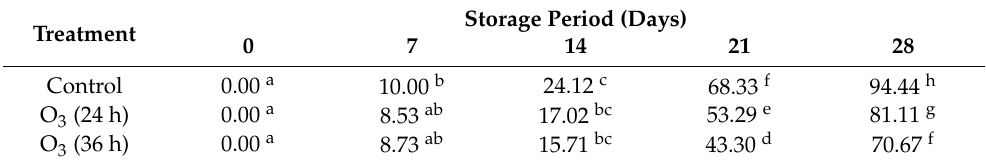
Table 2. Effect of gaseous ozone (0.25 mg/L) on disease incidence of mango fruit inoculated with L. theobromae , stored at 10 °C for three weeks and ripened at ambient temperature for seven days. Treatment